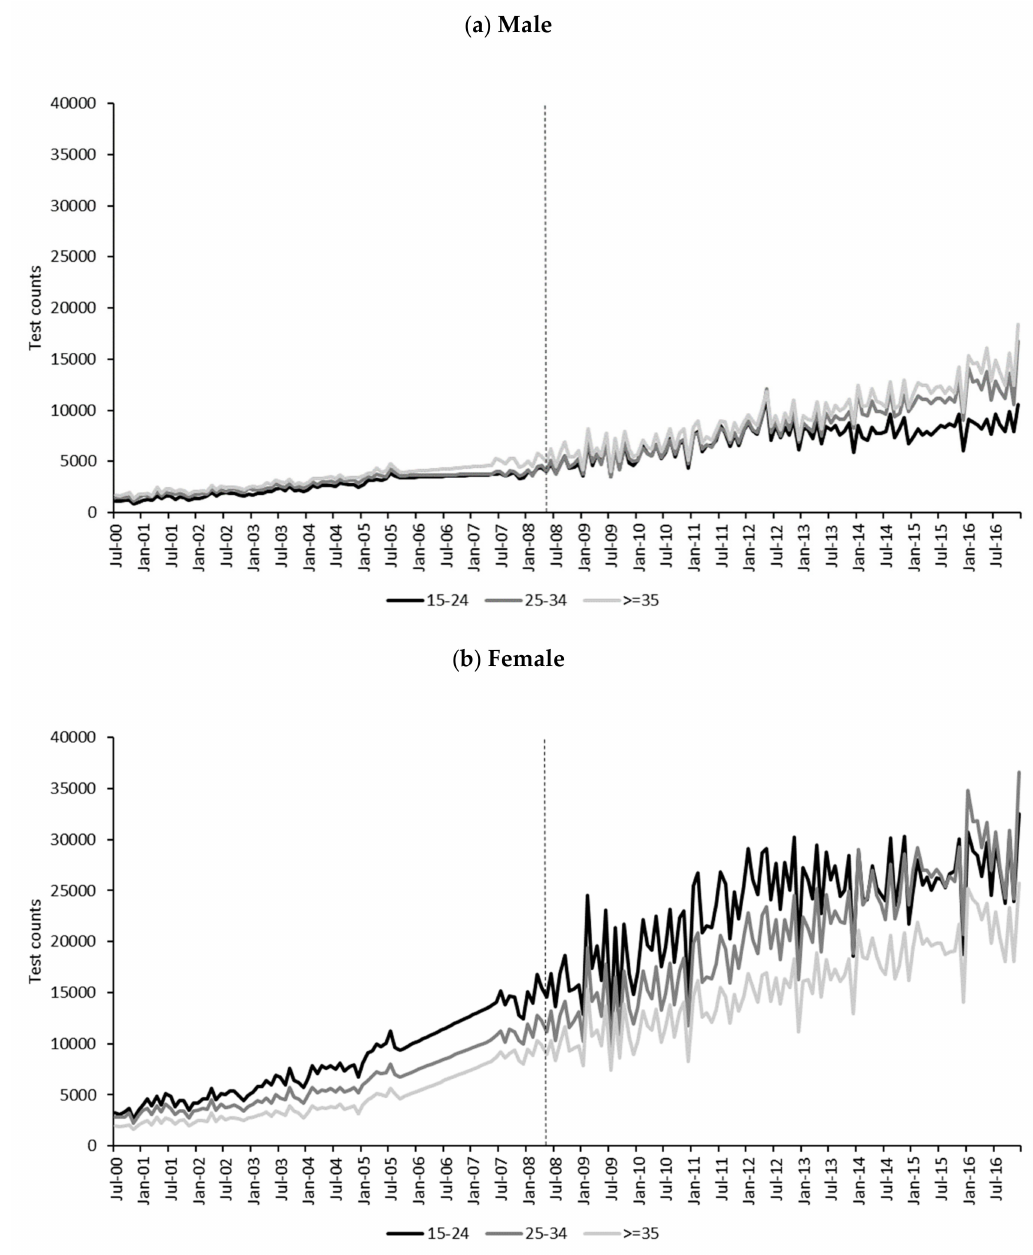
Figure 4. Monthly chlamydia test counts by gender and age group, July 2000 to December 2016. Alcopops tax intervention point indicated by vertical dotted line at May 2008. Test counts interpolated within age group and gender between November 2005 and May 2007 due to missing data. Test counts shifted back by 1 month to represent date of service better (rather than date